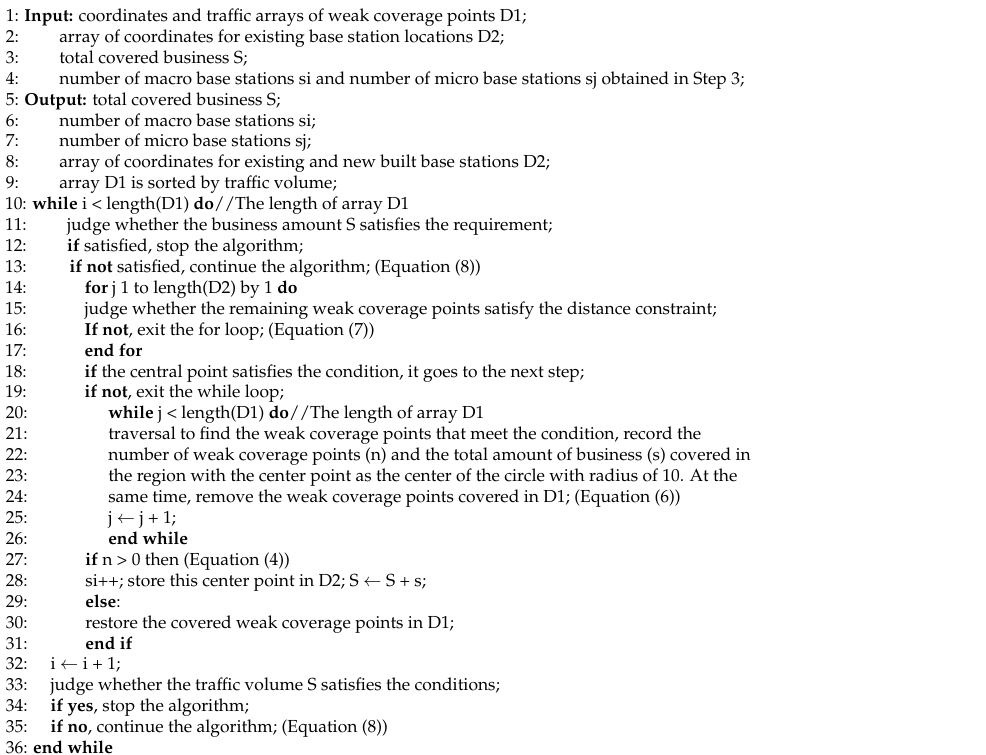
Algorithm 4: Algorithm for determining the number of micro base stations based on grid